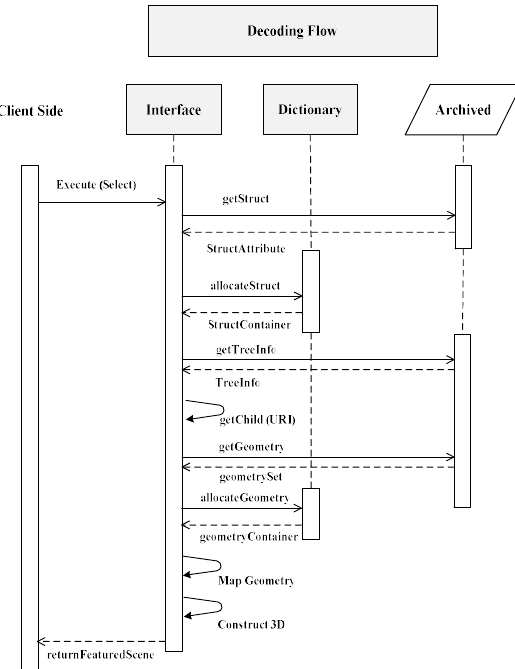
Figure 6. The decoding process flow